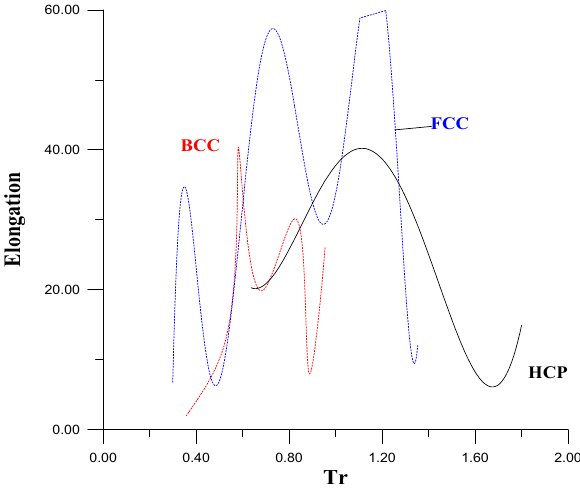
Figure 4. The relations between values of elongations and Trs for pure